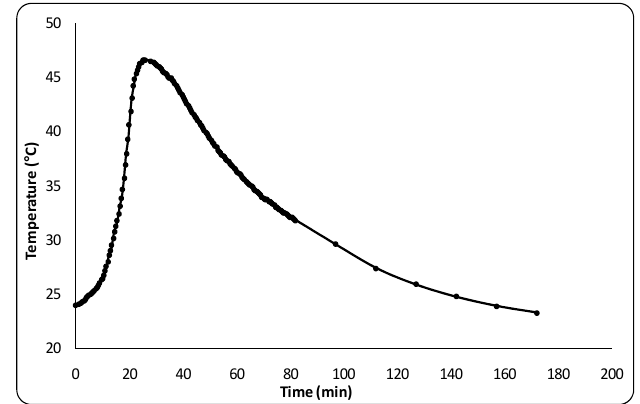
Figure 12. Temperature of gypsum plaster and water specimen versus time.